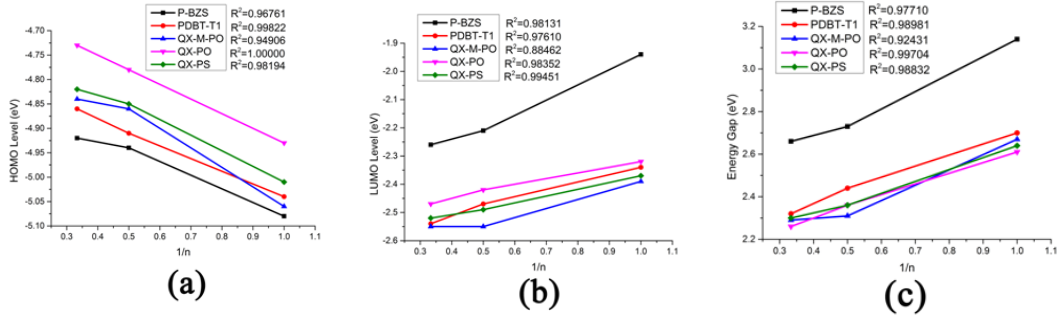
Figure 4. The relationship between energy levels of polymers and the reciprocal of conjugated chain (1/ n ): ( a ) HOMO; ( b ) LUMO; and ( c ) energy gap.